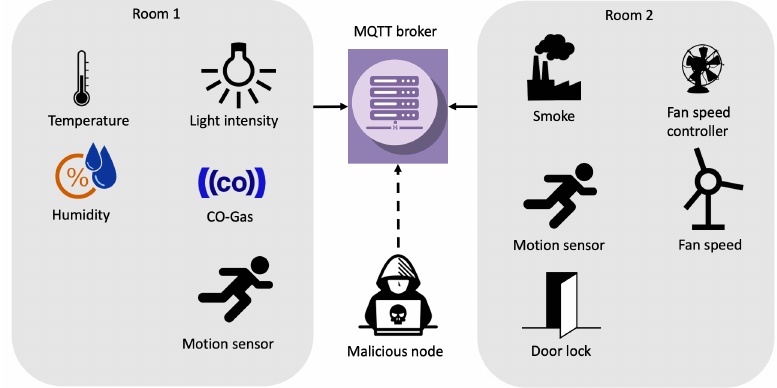
Figure 1. The scenario considered in